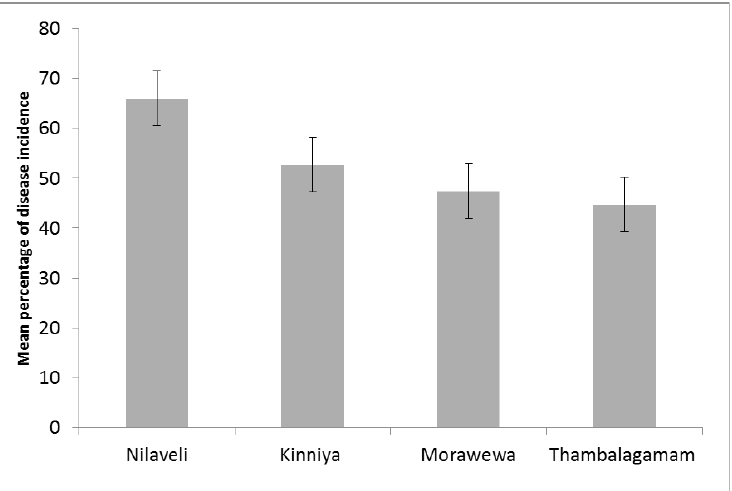
Figure 3 : Incidence (%) of fruit rot disease in C. moschata . In each region disease incidence was determined in four different fields and the mean percentage of disease incidence is presented in this chart. Standard Error of mean =